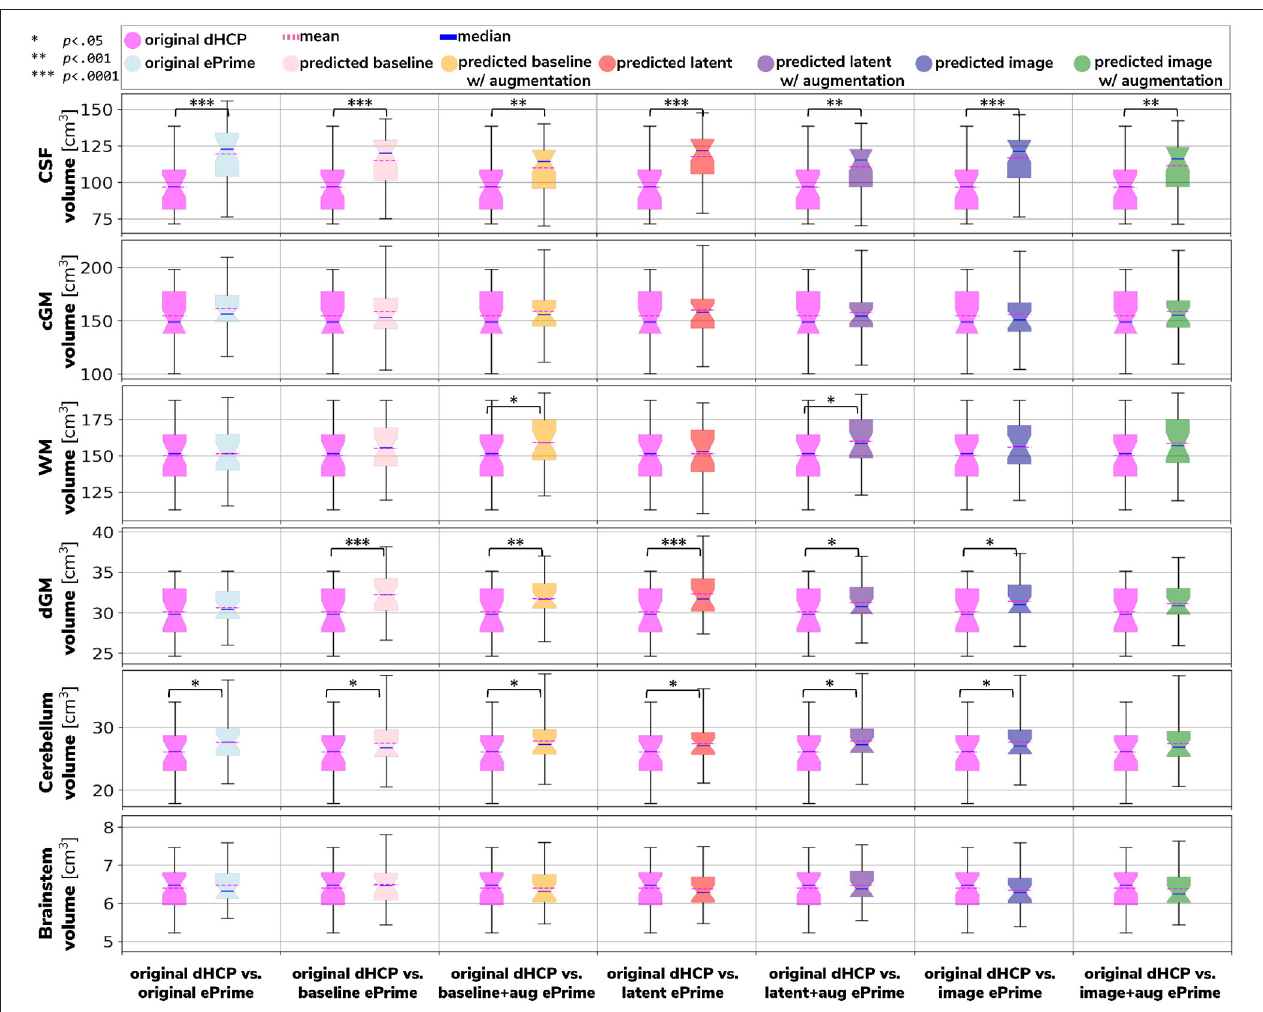
FIGURE 6 | Comparison of volume measures for our six tissue types (CSF, cGM, WM, dGM, cerebellum, and brainstem) between original Draw-EM dHCP segmentations and original Draw-EM ePrime segmentations (first column), or between original Draw-EM dHCP segmentations and ePrime segmentations obtained with the six trained models (columns 2–7). Linear regressions were performed in the comparable data subsets testing the effects of cohort on volumes, controlling for PMA, GA, and sex (volume ∼ cohort + PMA + GA + sex). The asterisks indicate a statistically significant effect of cohort in the linear